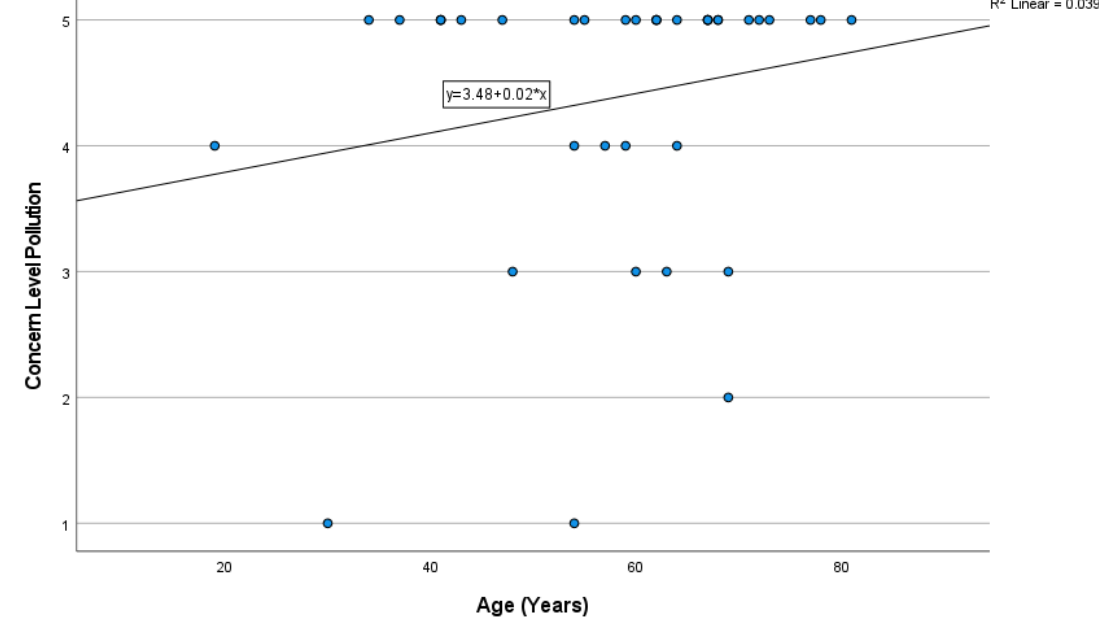
Figure 3. Relationship Between Concern Scores Regarding Pollution and Age with Statistically Significant Slope ( p = 0.009; standardized Beta β = 0.433).